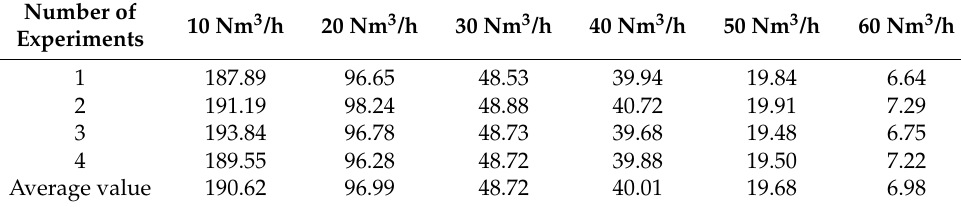
Table 6. Liquid content in Case 1 at M 2 (g/m 3